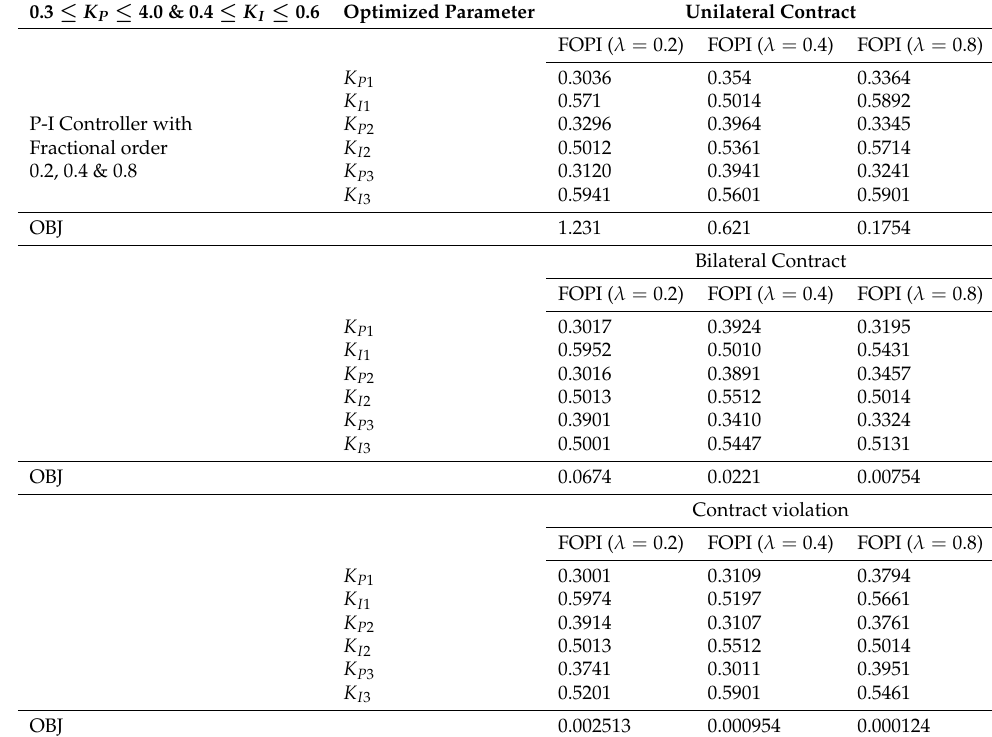
Table 10. Gain values of FOPI controller to (test system 2) hybrid thermal − wind − solar system with DGS constant time delays τ d = 7.365 s and RLP type of load for ± 0.02 MW ( p . u